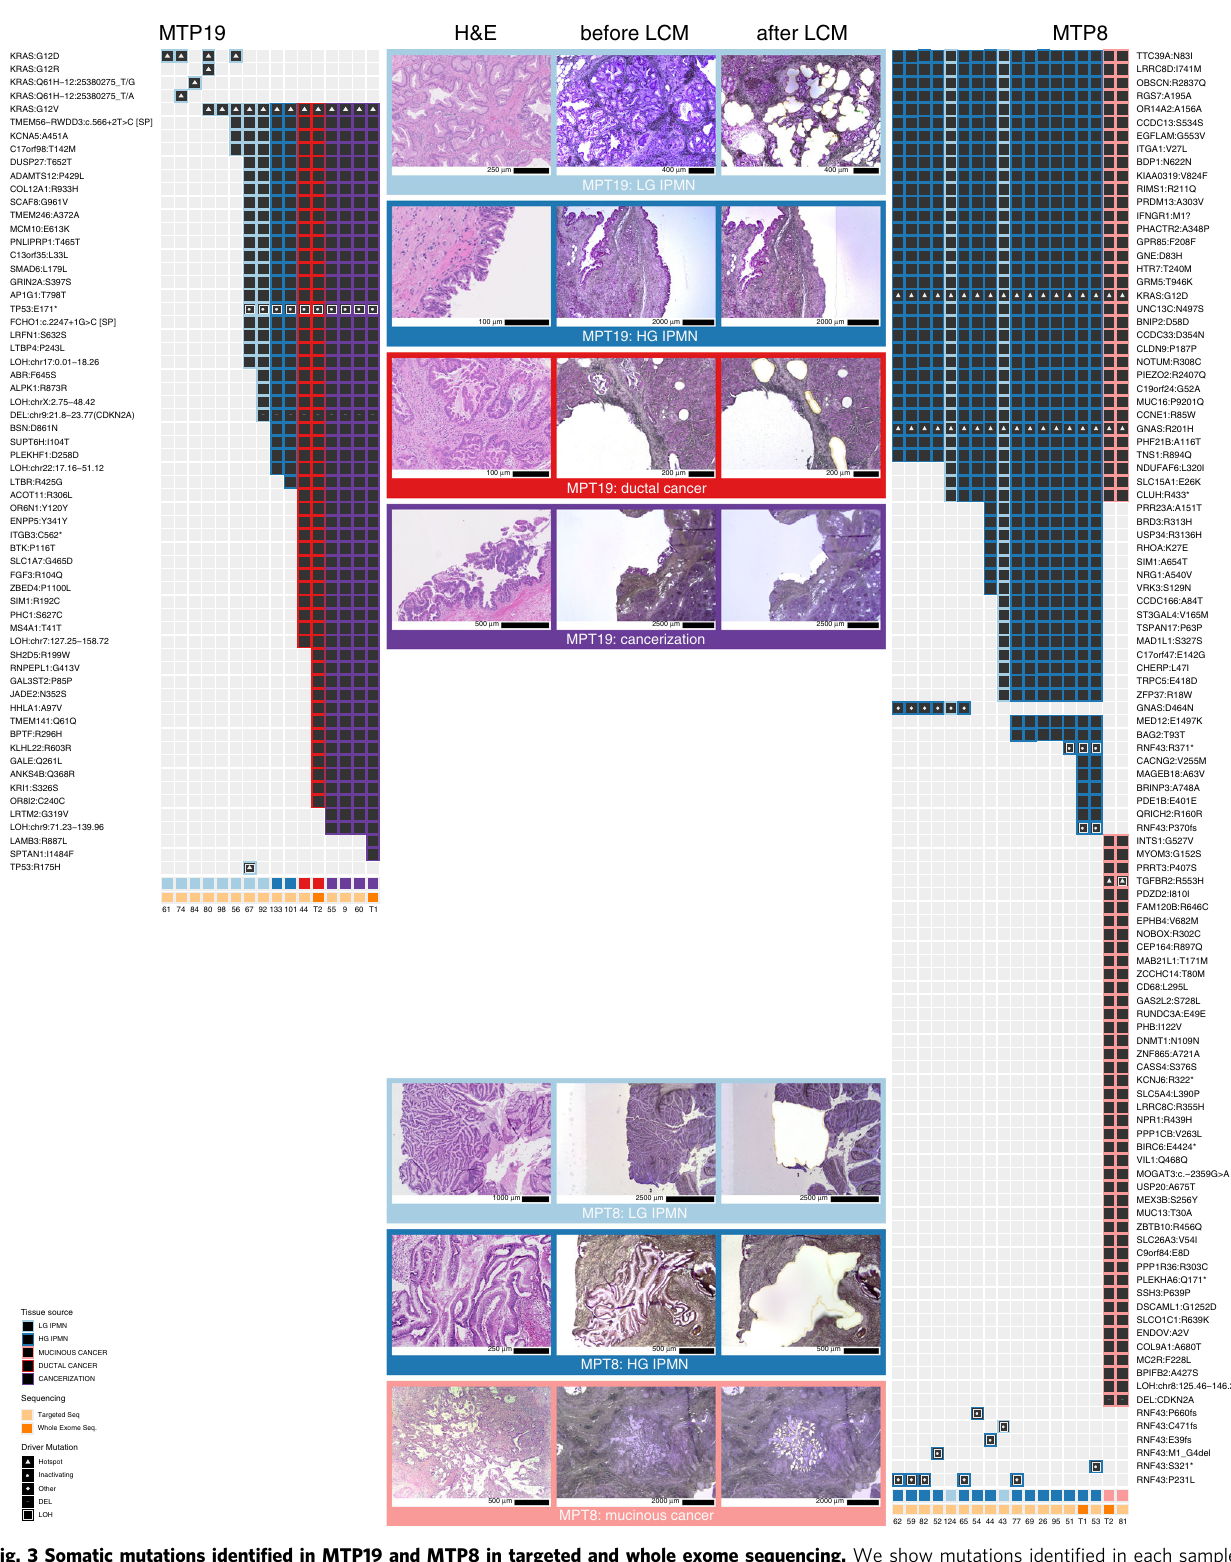
Fig. 3 Somatic mutations identi fi ed in MTP19 and MTP8 in targeted and whole exome sequencing. We show mutations identi fi ed in each sample, including low-grade IPMN (light blue), high-grade IPMN (dark blue), ductal cancer (red), mucinous cancer (pink), and cancerization (purple). The type of sequencing analysis (targeted or whole exome) performed for each sample is indicated in a track on the bottom. Representative images of neoplastic tissue stained by hematoxylin and eosin, as well as isolated regions before and after laser capture microdissection are shown for MTP19 and